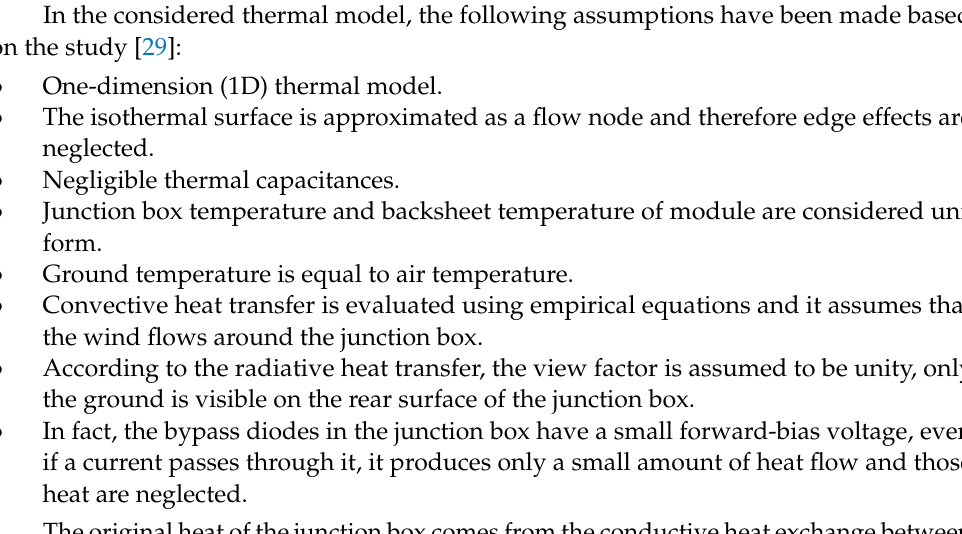
Figure 7. Heat exchange of junction box.